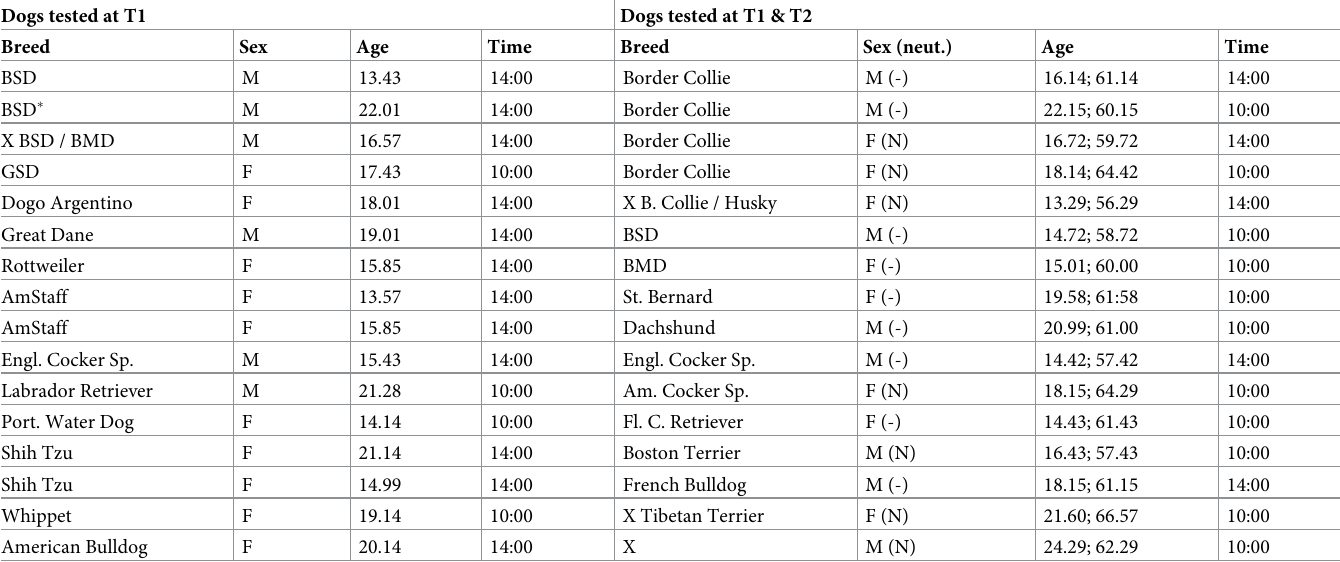
The left panel shows dogs only tested at T1 (N = 16 puppies), the right panel shows dogs also tested at T2 (N = 16 young adults). Neuter status is only shown for T2 (puppies were not neutered). Dog age is shown for each test stage, and time of testing was the same on both occasions.